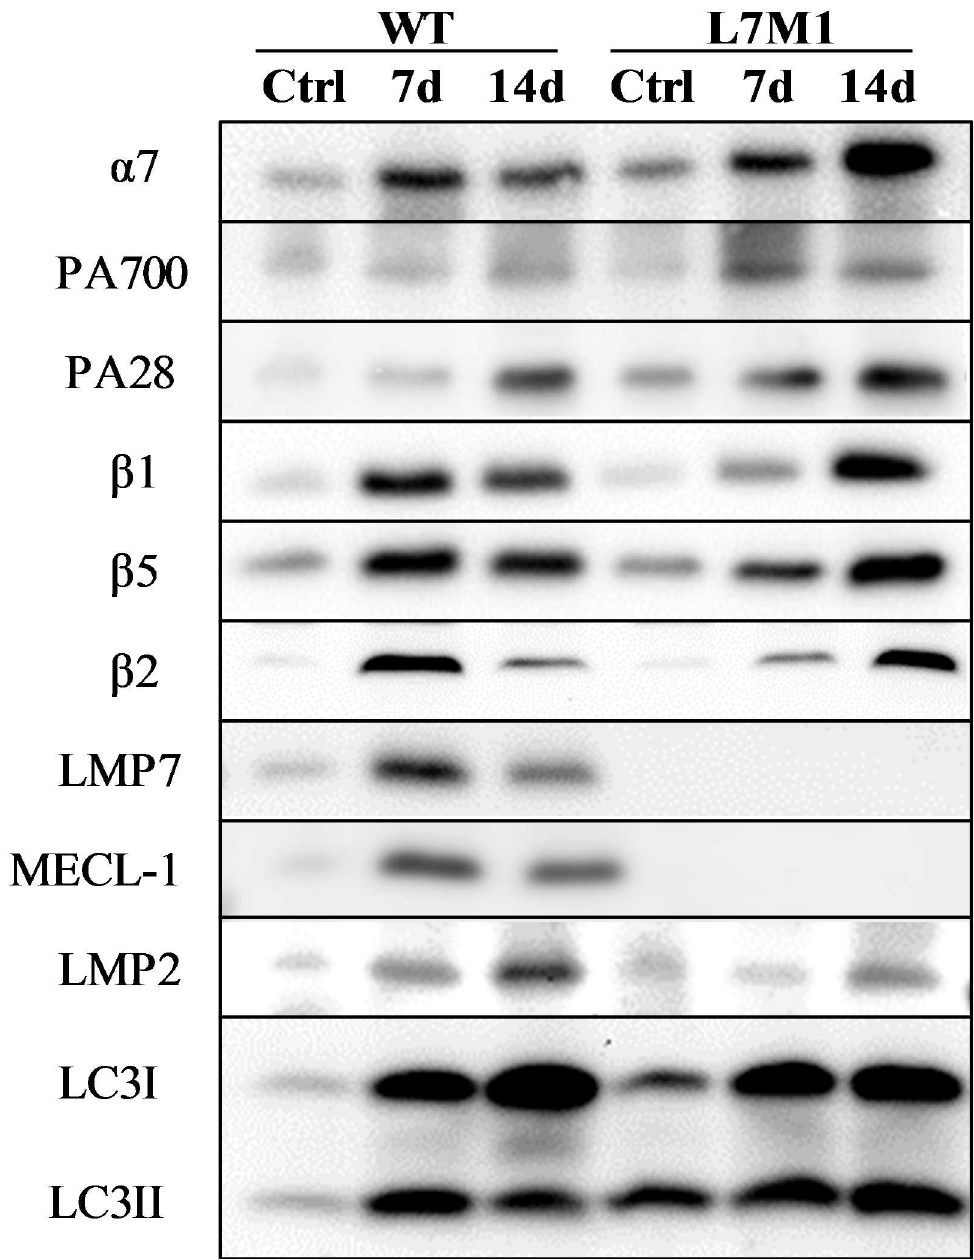
Fig 1. Representative Western blots. See Methodsand Table 1 for experimental proceduresand specific antibody information. These immunoblots show the gastrocnemius muscles of WT and L7M1 mice in control (innervated, Ctrl), and following7 (7d) and 14 days (14d) of denervation. The selectedantibodies are identifiedon the